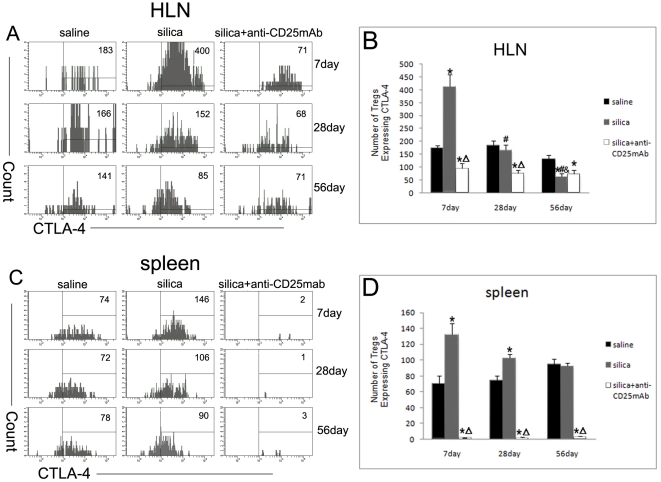
The expression of CTLA-4 in Treg cells in the HLN and spleen.CTLA4 expressed in CD4+CD25+FOXP3+ Treg cells of HLN (A) and spleen (C) was assayed by flow cytometry. (n = 5) The number of Treg cells expressing CTLA4 of HLN (B) and spleen (D) was shown in the graph. (n = 5) (*, as compare with the saline control group, P<0.05; △, as compare with the silica group, P<0.05; #, as compare with 7day of the same group, P<0.05; &, as compare with 28day of the same group, P<0.05).